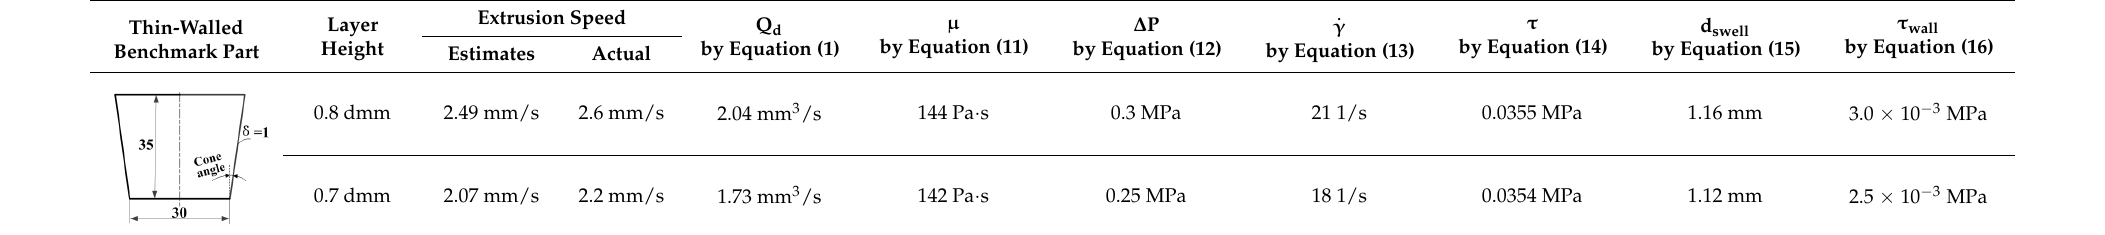
Table 1. Experimental conditions and data.